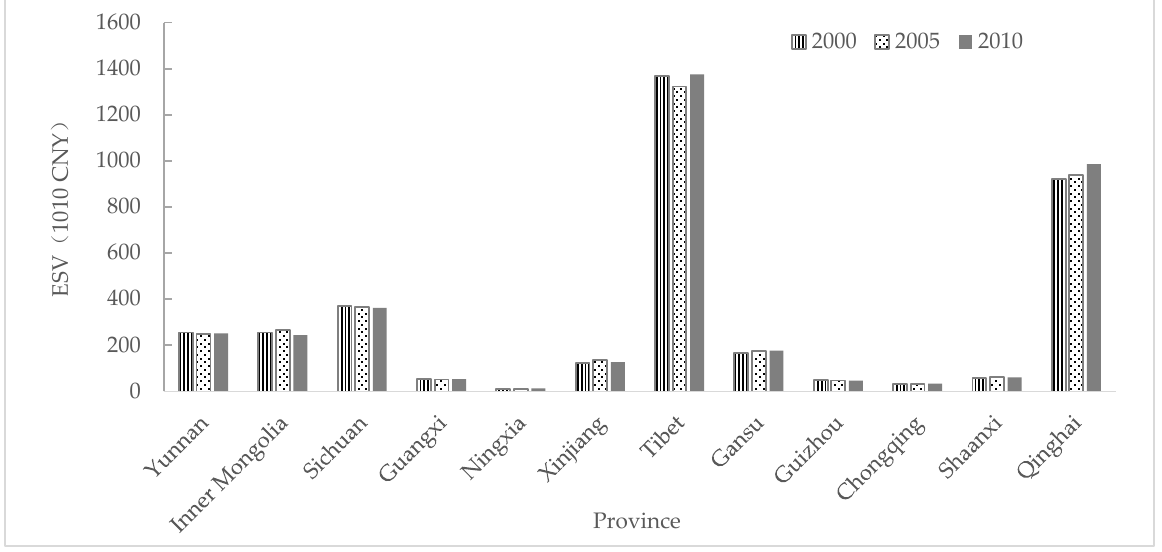
Figure 8. Ecosystem services values of the national nature reserves in each province of western China.